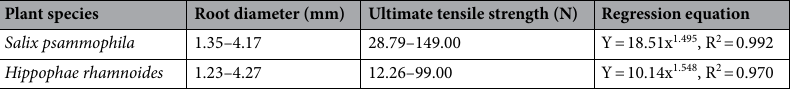
Table 2. Ultimate anti-fracture force and its regression equation with root diameter of two plants.